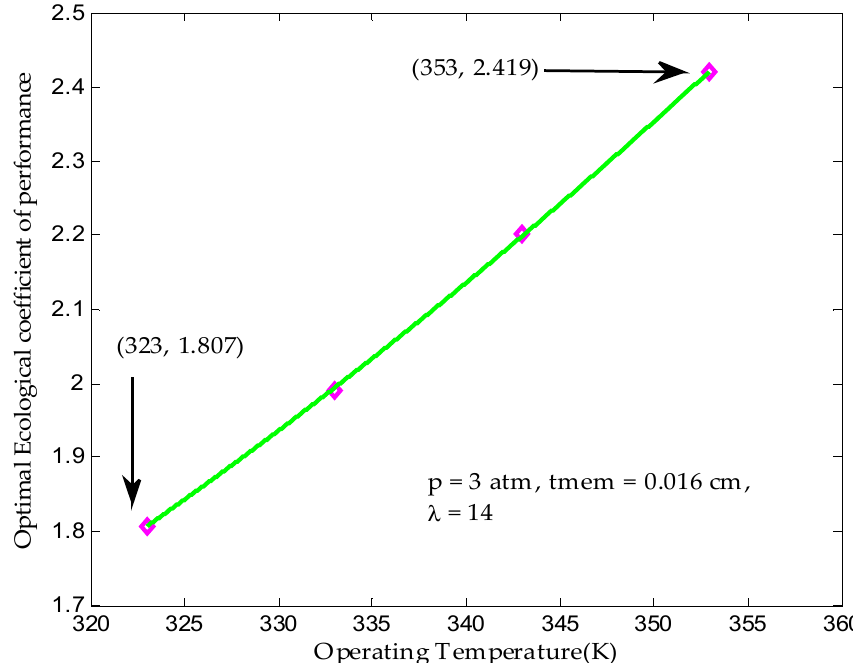
Figure 15. Optimal ECOP varying with operating temperature.